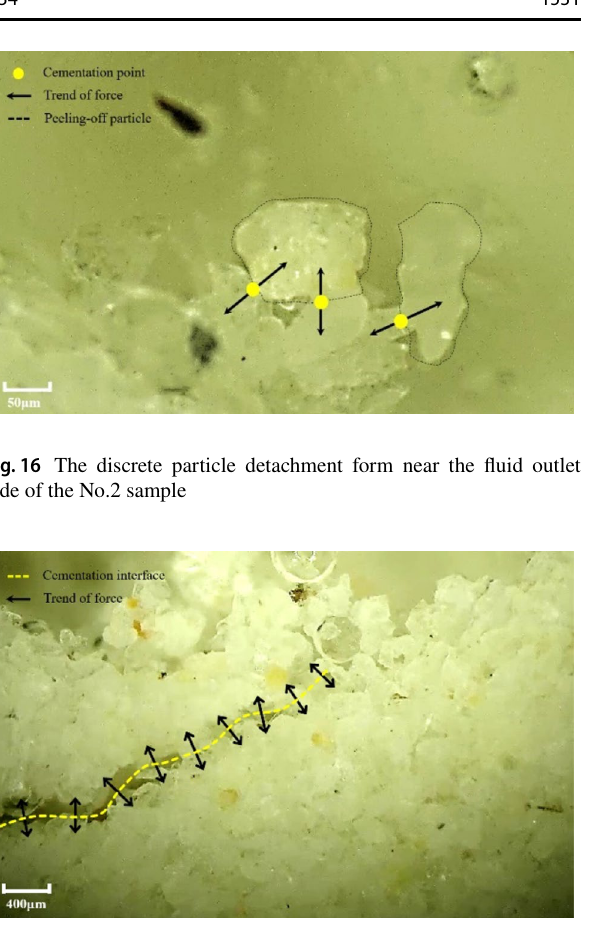
Fig. 17 The weakly-cemented interface detachment form near the fluid outlet side of the No.8